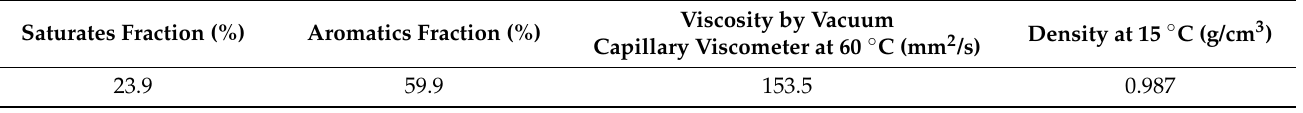
Table 2. Basic properties of the rejuvenating agent